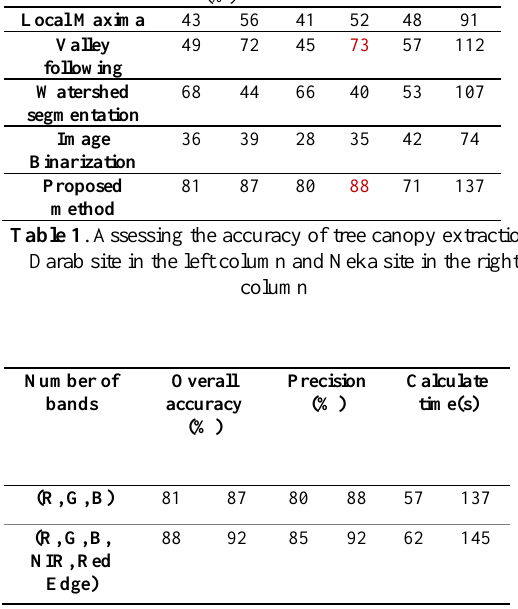
Table 2. Evaluation of tree crown extraction accuracy by increasing the number of spectral bands. Darab site in the left column and Neka site in the right